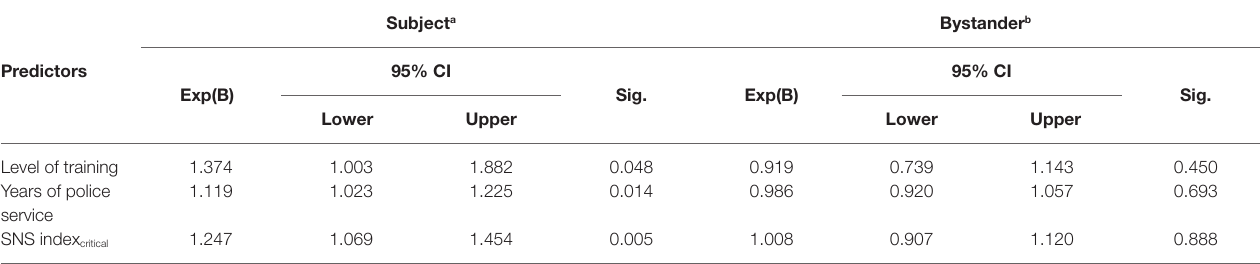
TABLE 7 | Logistic regressions for training, experience, and stress reactivity on lethal force